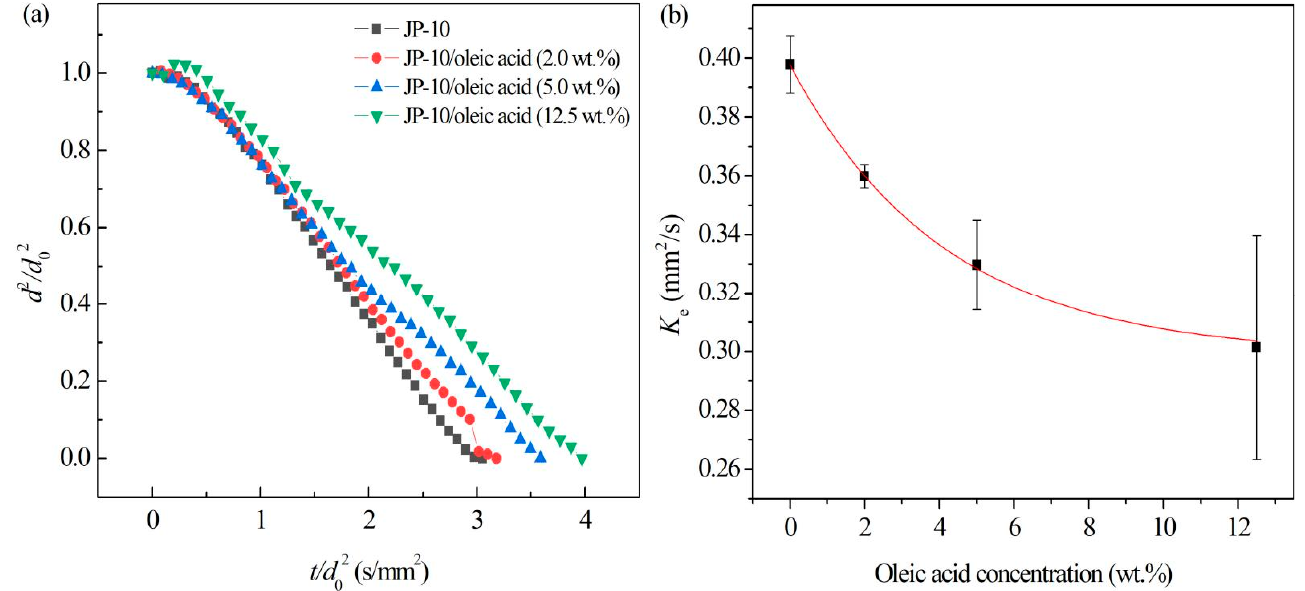
Figure 9. Evaporation of JP-10/oleic acid fuels at different oleic acid concentrations. ( a ) Variation of droplet diameter with the evaporation time, ( b ) evaporation rates at different oleic acid concentrations.